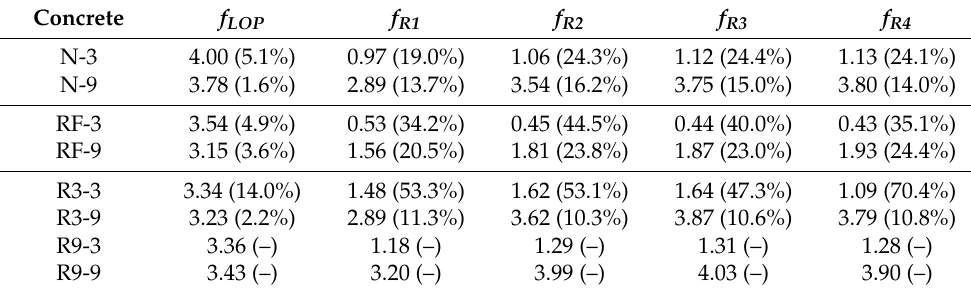
Table 5. Residual flexural tensile strength results.